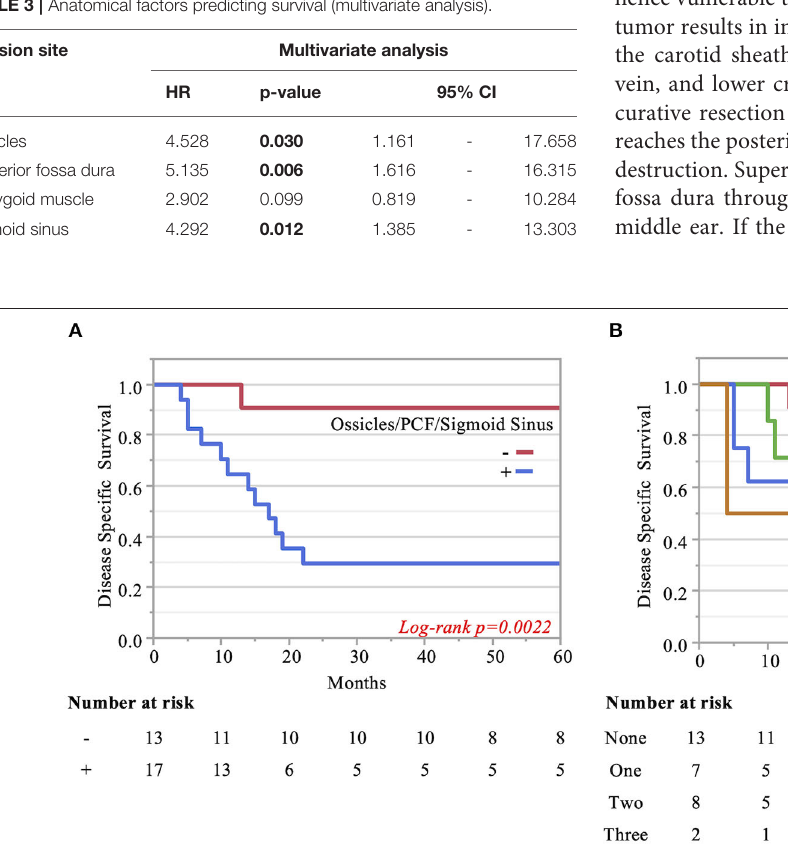
Frontiers in Oncology |